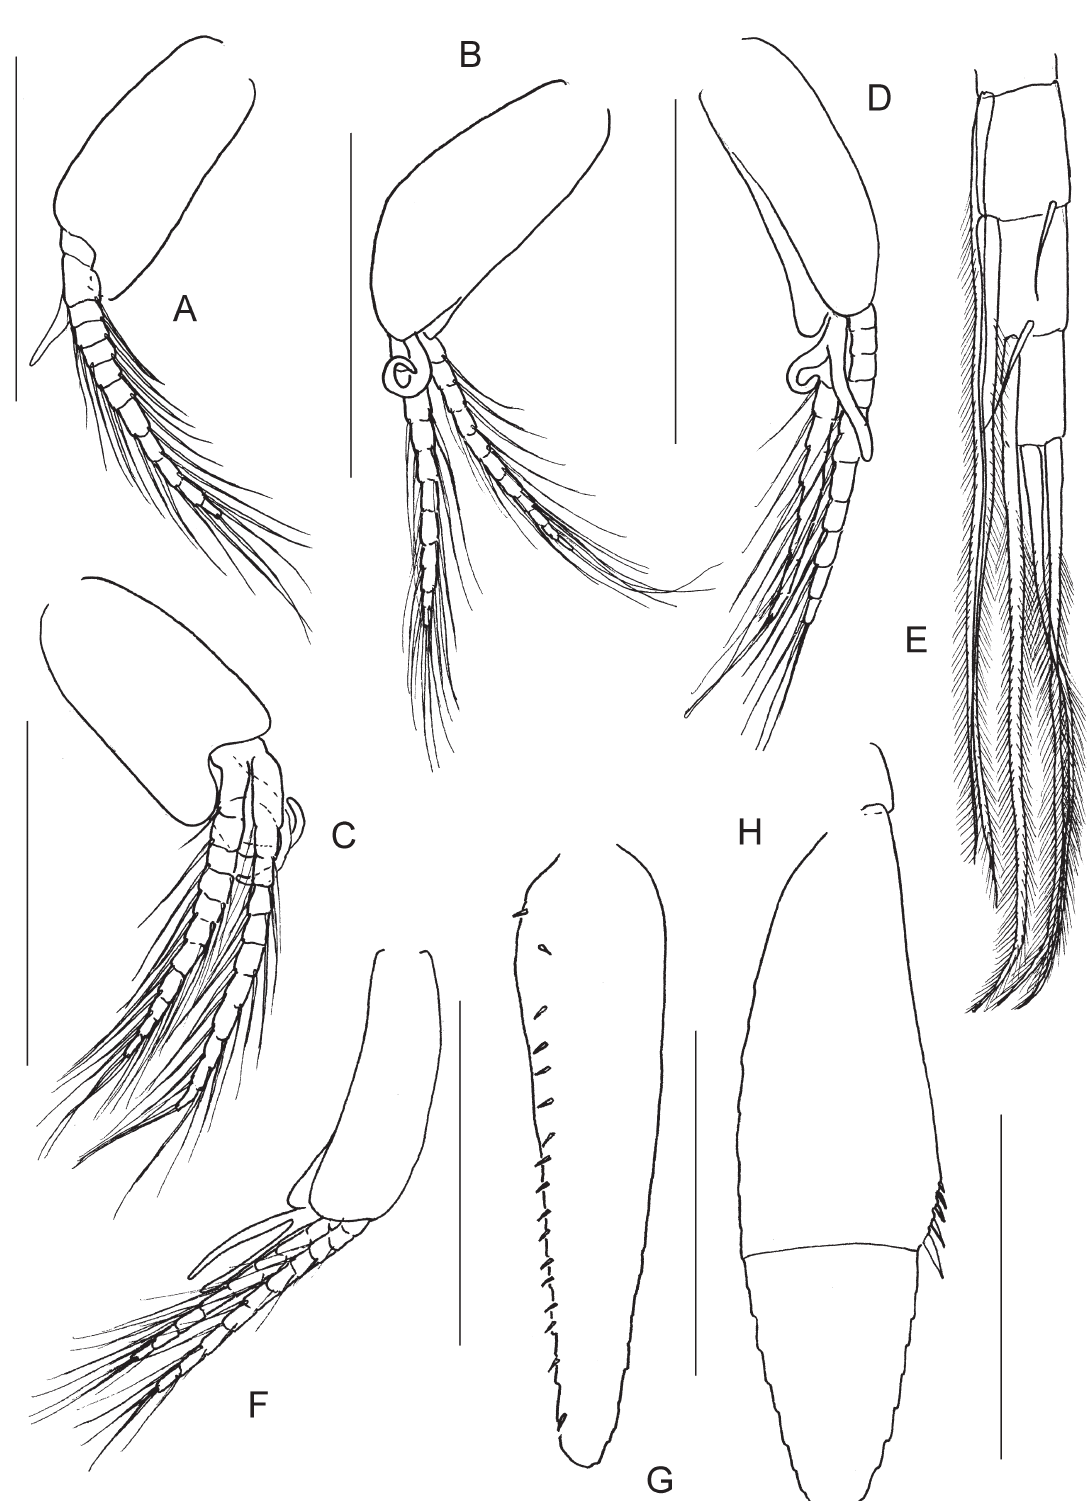
Fig. 28. Siriella talbotae sp. nov., holotype, ♂, length 5 mm, Lizard Island, Queensland, Australia. A . Pleopod 1, lateral view. B . Pleopod 2, lateral view. C . Pleopod 3, anterior view. D . Pleopod 4, lateral view. E . Distal part of pleopod 4. F . Pleopod 5, lateral view. G . Endopod of uropod, ventral view. H . Exopod of uropod, ventral view. Scale bars: A–D, F–H = 0.5 mm; E = 0.25